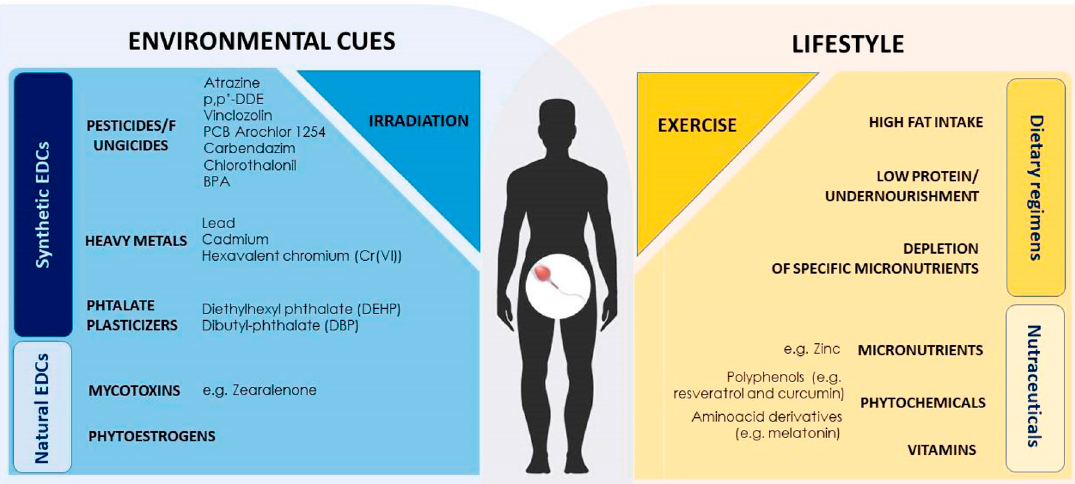
Figure 3. Environmental and dietary factors impacting on spermatogenesis and sperm quality. Several factors are able to influence male fertility through epigenetic modifications targeting di ff erent cells involved in spermatogenesis. The figure resumes the relevant environmental agents known to a ff ect male fertility as well as improper dietary regimens. Nutraceutical supplements reported to positively impact on spermatogenesis are also listed.